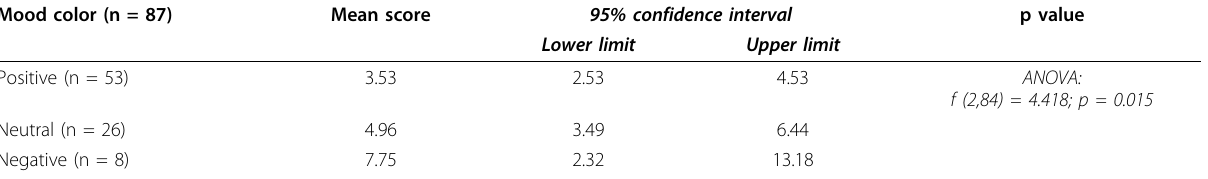
Table 6 Association between post-HT depression score and post-HT mood color choice Mood color (n =